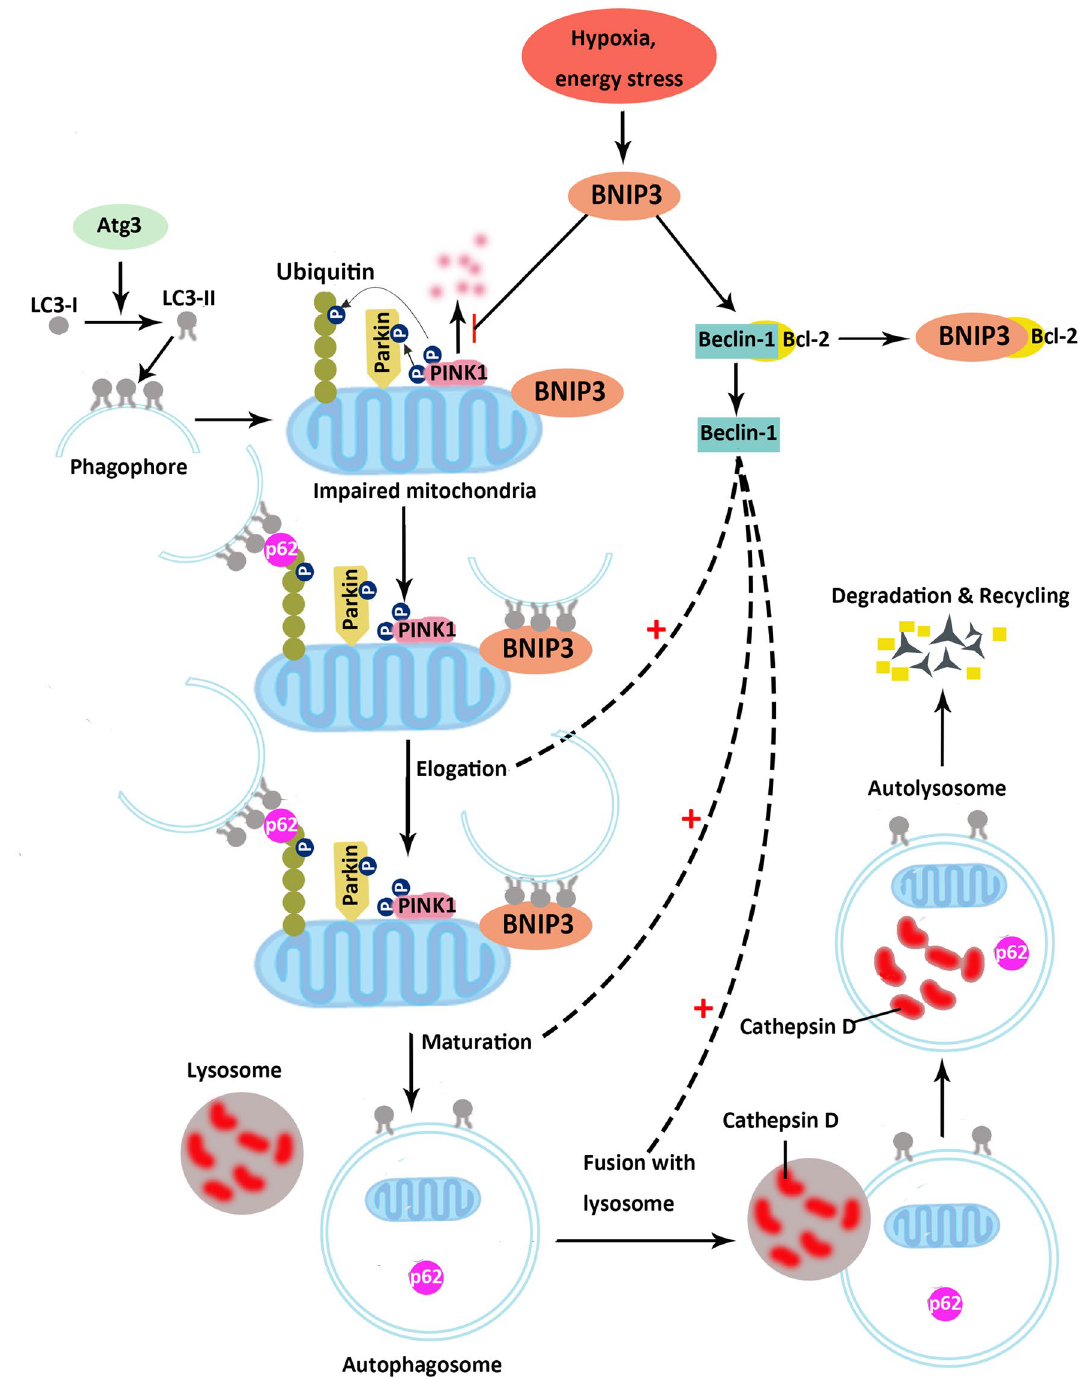
Figure 5. The molecular mechanism of mitophagy. Under hypoxia or energy stress, BNIP3 inhibits the degradation of PINK1 and leads to the accumulation of PINK1 on the outer mitochondrial membrane. PINK1 phosphorylates both Parkin and ubiquitin. Phospho-ubiquitin interacts with LC3-II coated phagophore through p62. BNIP3 can also directly bind with LC3-II and mediate the interaction of phagophores, impairing mitochondrial function. In addition, BNIP3 competes the binding site of Bcl-2 protein with Beclin-1 and releases Beclin-1. The free Beclin-1 subsequently forms the complexes and participates in autophagosome elongation, maturation, and fusion with lysosome. Finally, the impaired mitochondria and p62 are degraded by cathepsin D. (Created by authors using Adobe Illustrator